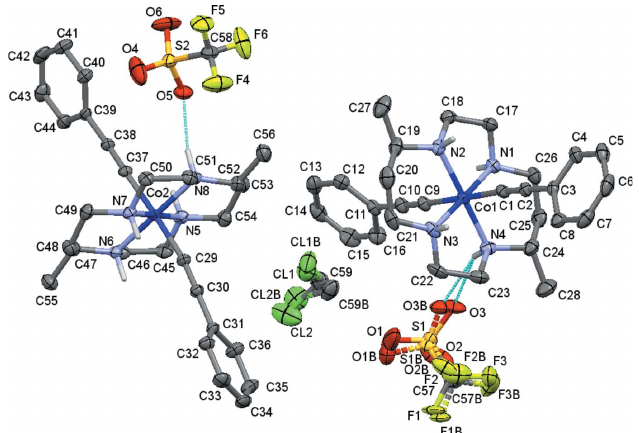
Figure 2 Displacement ellipsoid plot (50% probability setting) for compound 2 , showing the atom-naming scheme and some of the hydrogen-bonding interactions (turquoise dashed lines). The OTf molecule comprising S2 is in position x (cid:5) 1, y , z . The carbon-bound H atoms and H-atom labels are omitted for clarity.